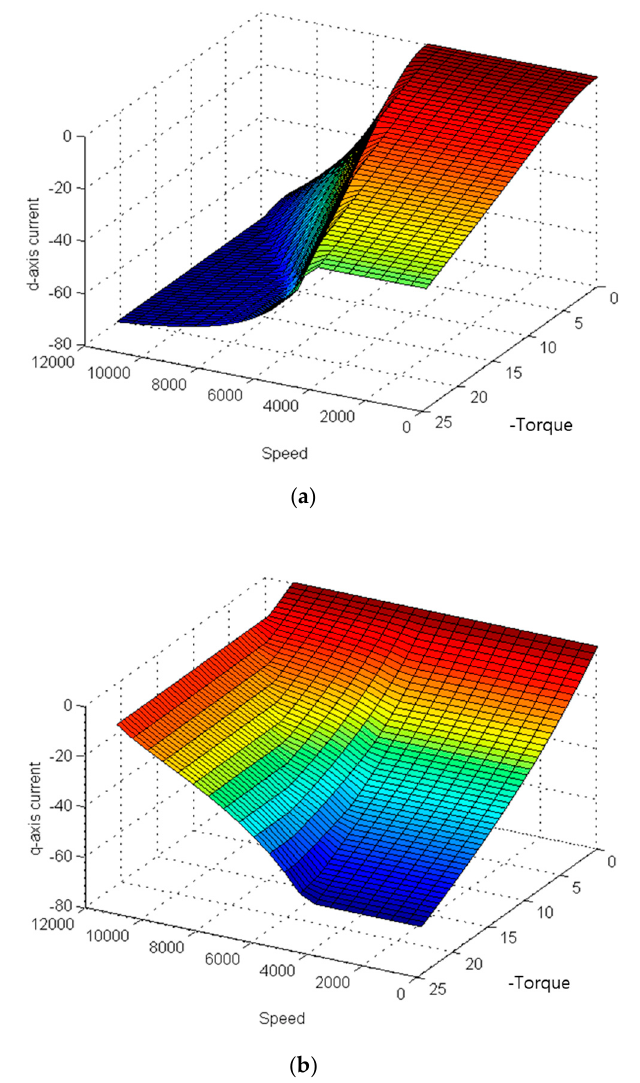
Figure 4. dq-axis current references for regenerative torque generation. ( a ) d-axis ( b ) q-axis